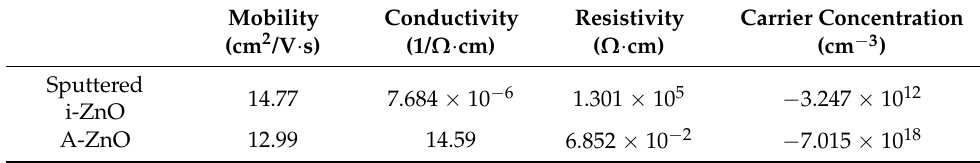
Figure 6. External quantum efficiency (EQE) of CIGS solar cells with i-ZnO and A-ZnO window layers with different thickness in ( a ) the full wavelength range (300–1100 nm), and the ( b ) short- wavelength region (~320–400 nm). Table 2. Electrical properties of sputtered i-ZnO and A-ZnO thin